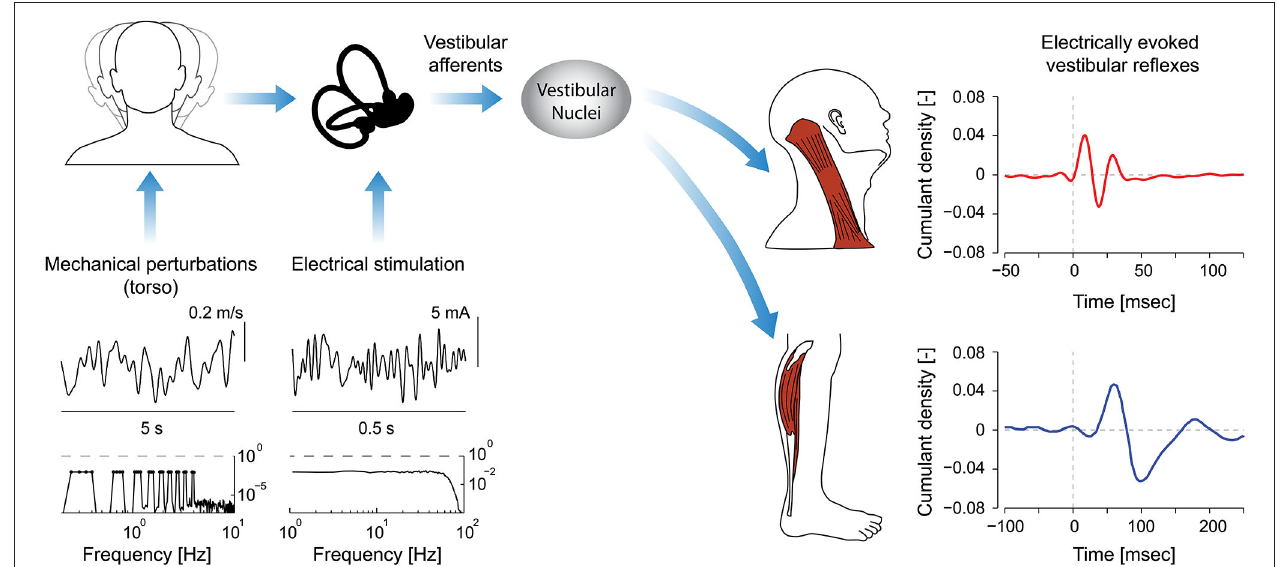
muscles are presented only in response to electrical stimuli with identical bandwidths (0–75 Hz). Afferent signals descend through the vestibular nuclei (VN) to axial and appendicular muscle motoneurons. The evoked reflexes in axial muscles have much shorter latencies than those in appendicular muscles (8 ms vs. 50 ms). Different time scales were used to illustrate the evoked responses (250 ms vs. 150 ms). (Data for cumulant density plots and perturbation/stimulation signals are adapted from Forbes et al., 2013a,b,